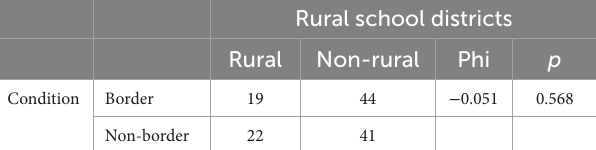
TABLE 3 Descriptive statistics of adjusted STAAR performance by school district